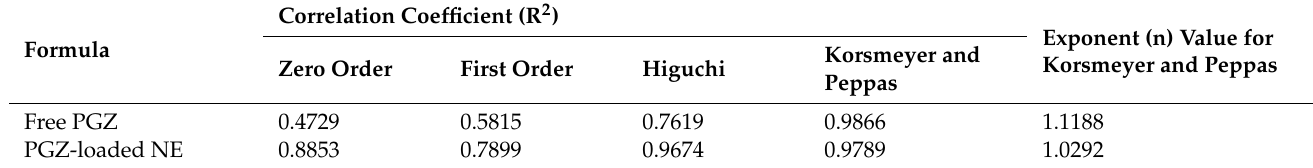
Table 5. The correlation coefficient value for different kinetic modeling